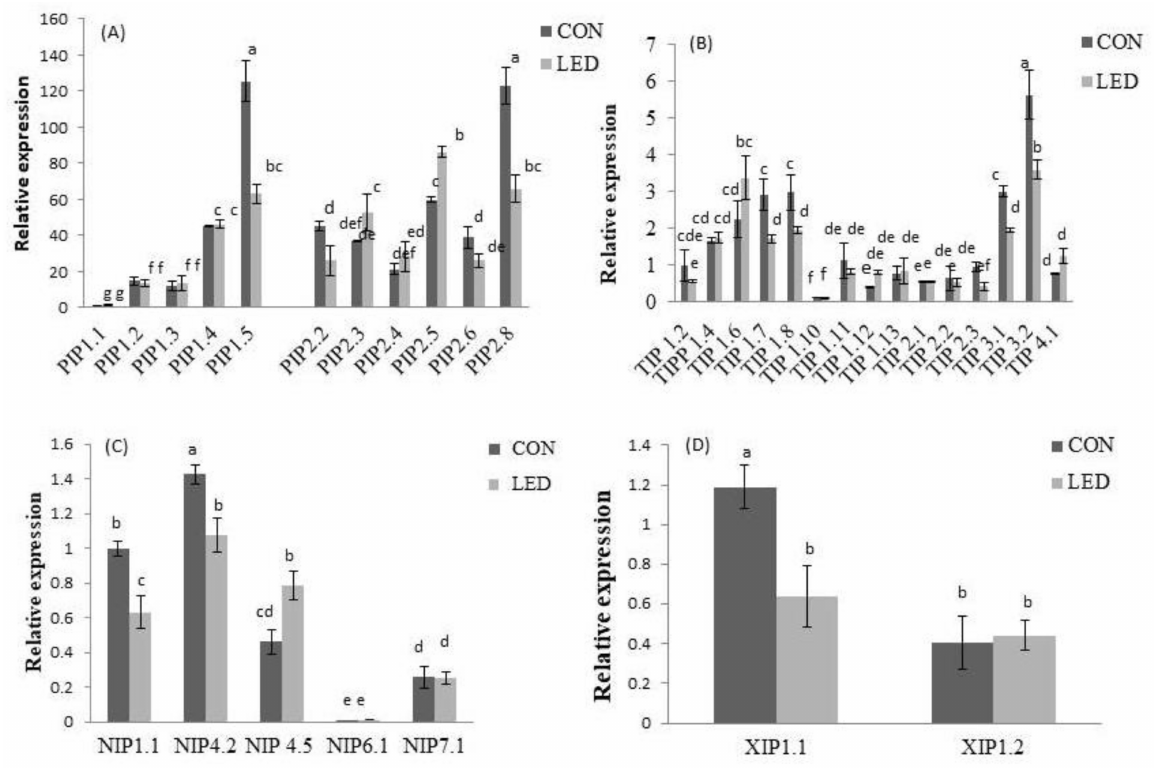
Figure 4. Relative expression of ( A ) PIP , ( B ) TIP , ( C ) NIP , and ( D ) XIP isoforms for Control (CON, unlighted) pepper seeds and irradiated R LED (LED) pepper seeds, after radicle emergence during germination (at 96 h of imbibition). Bars are means ± SE ( n = 3). The different letters indicate significant differences ( p < 0.05, Tukey’s test) between treatments.